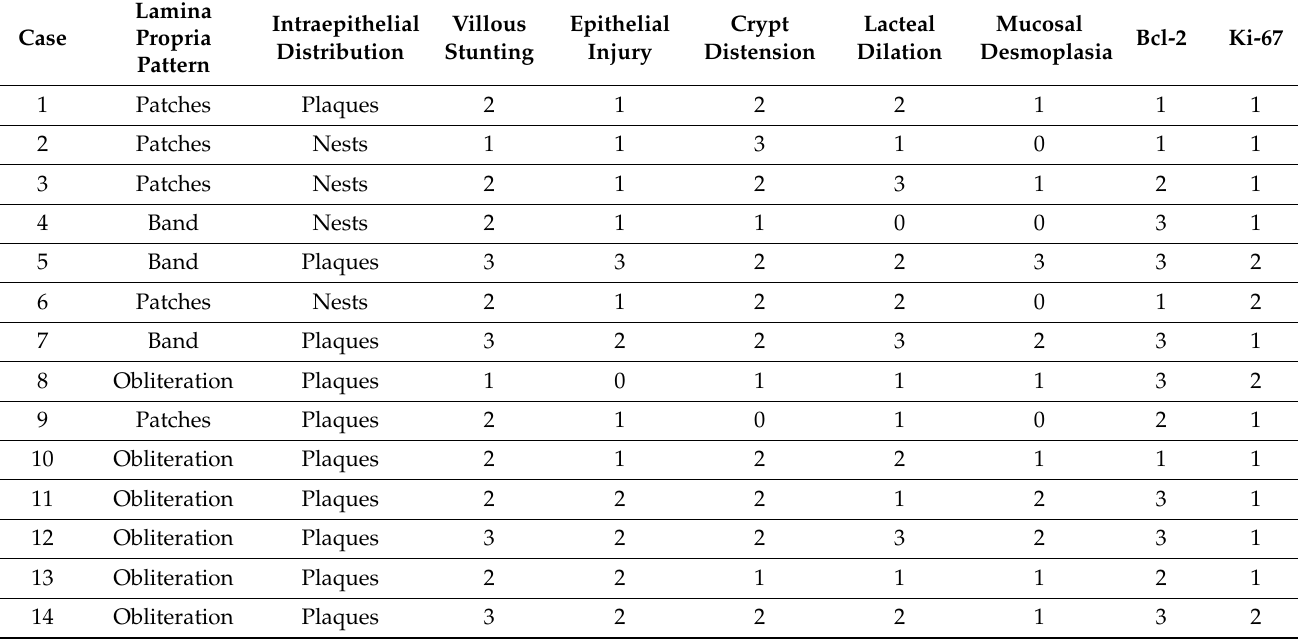
Table 2. Feline epitheliotropic duodenal T-cell lymphomas: Results of the histopathological